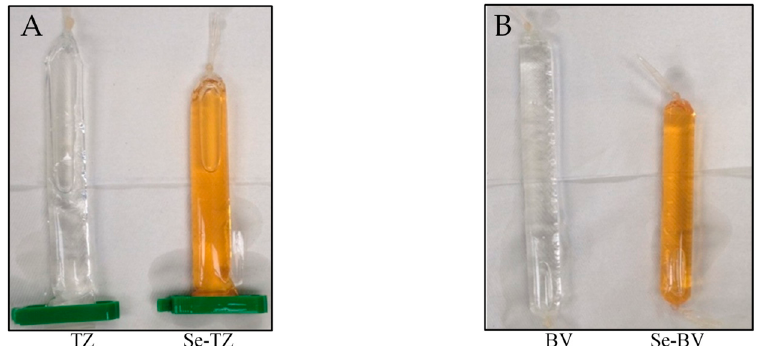
Figure 2. Dialyzed selenium-conjugated antibody products. After 72 h of conjugation time in pH 8.5 borate buffer after 72 h of dialysis against PBS pH 7.4, an orange color was observed for both selenium-antibody reactions. ( A ) Trastuzumab and Selenotrastuzumab. ( B ) Bevacizumab and Selenobevacizumab.